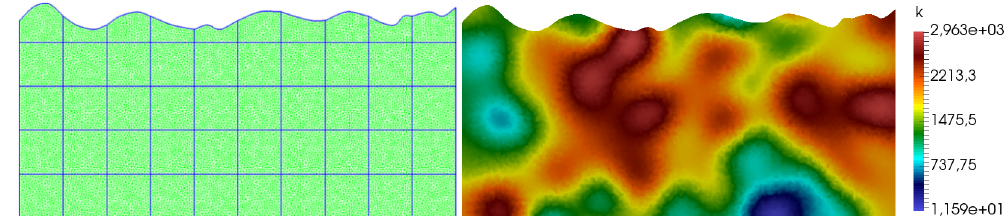
Figure 4. Computational grids and heterogeneous properties for Tests 1.DBC, 1.NBC, 1.RBC (two-dimensional problem). Left : Coarse grid (blue color) and fine grid (green color). Right : Heterogeneous coefficient k s ( x ) .